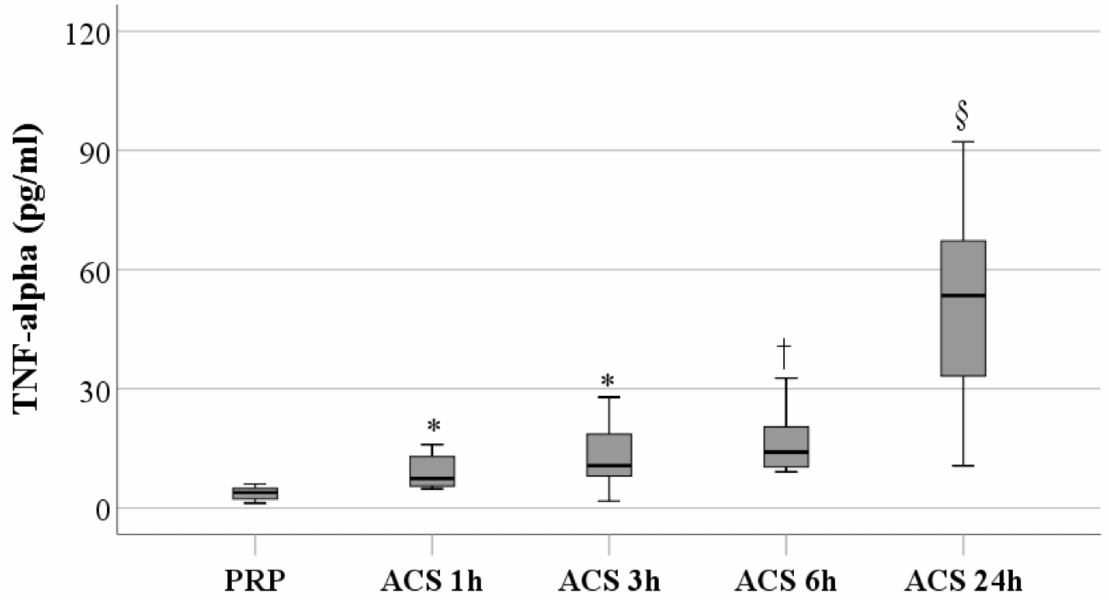
Figure 5. TNF- α levels of PRP and ACS with different incubation times. * indicates a significant difference as compared to PRP; † indicates a significant difference as compared to PRP and ACS 1 h; § indicates a significant difference as compared to PRP and ACS 1 h, 3 h, 6